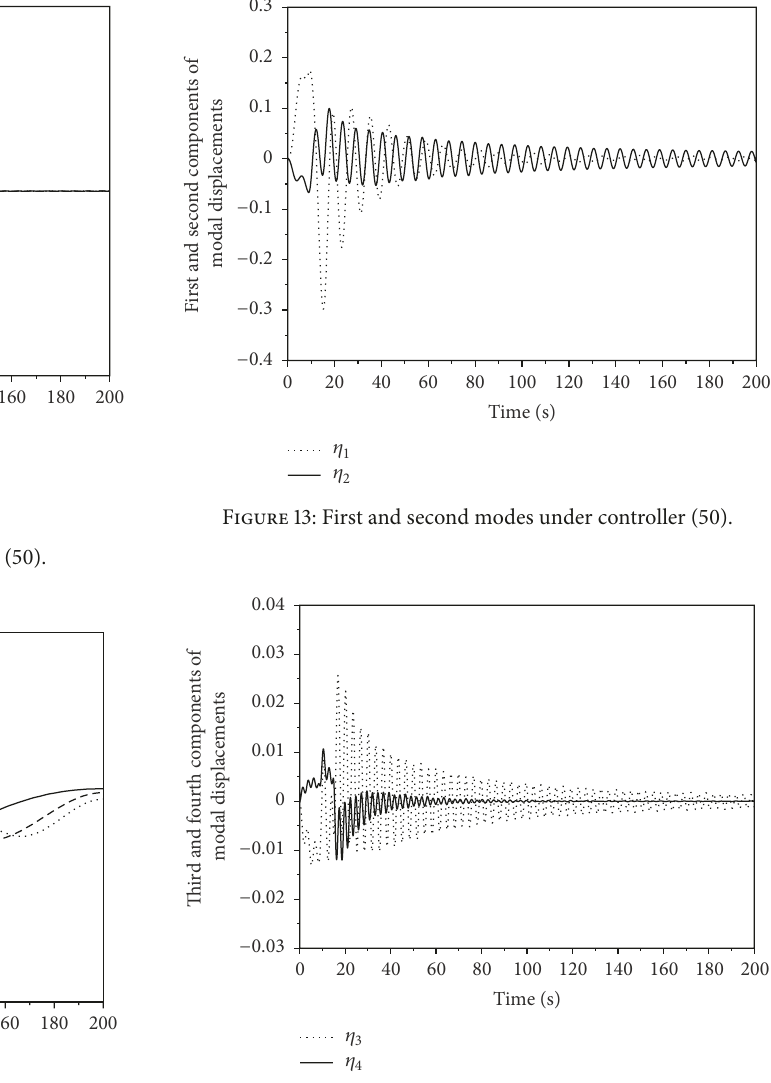
Figure 14: Third and fourth modes under controller